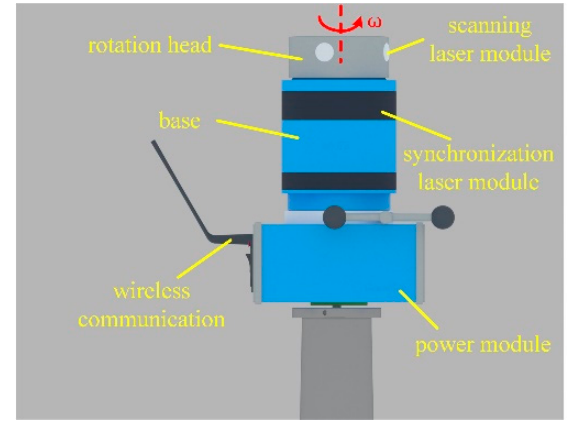
Figure 1. Transmitter configuration.